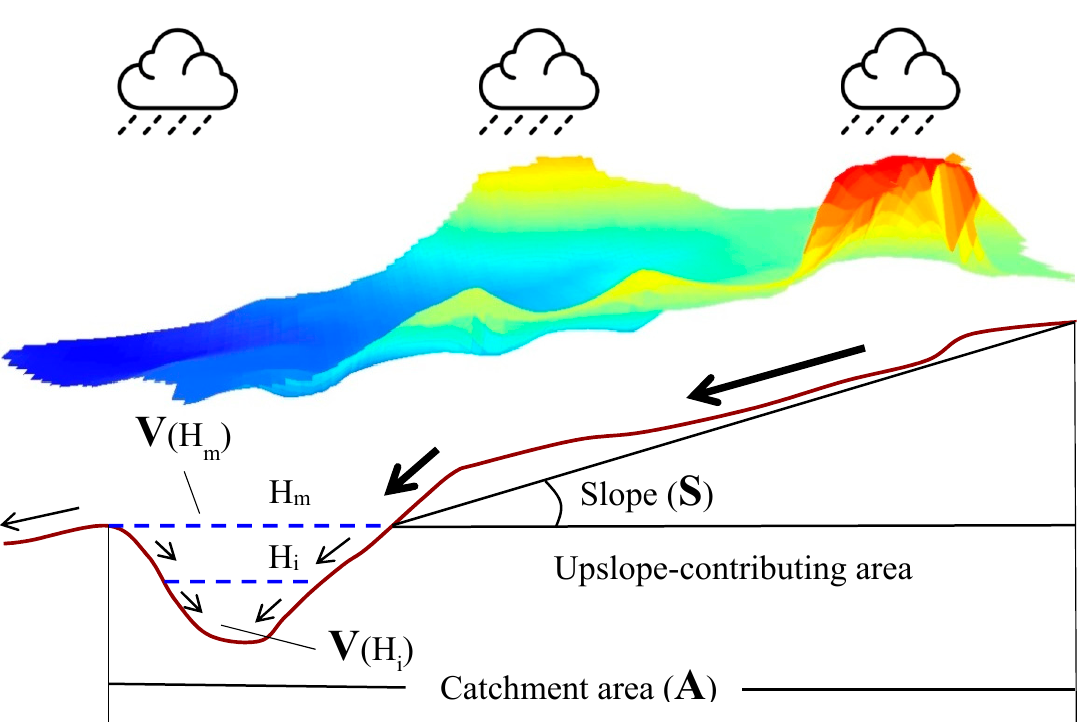
Figure 1. Profile of a typical topographic depression. The area embraced by the upper horizontal dashed blue line and the land surface is a depression. H m is the maximum water depth in the depression when it is completely inundated, and H i is any depth smaller than H m . V(H m ) and V(H i ) are the maximum ponding volume and the volume at the depth H i , respectively. The flow directions of the surface runoff are represented by arrows; thicker ones denote runoff from the upslope-contributing area of the depression.